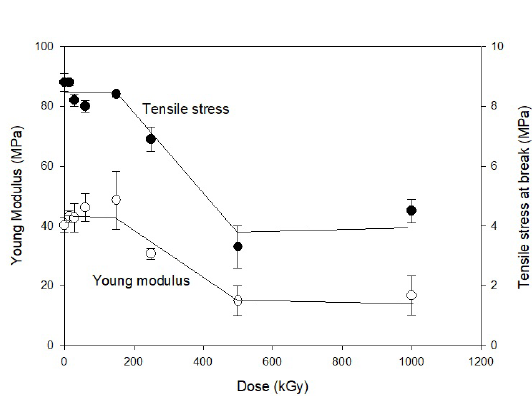
Figure 6. Young modulus and Tensile stress versus absorbed dose for gamma-irradiated green LLDPE composite in air, at room temperature.